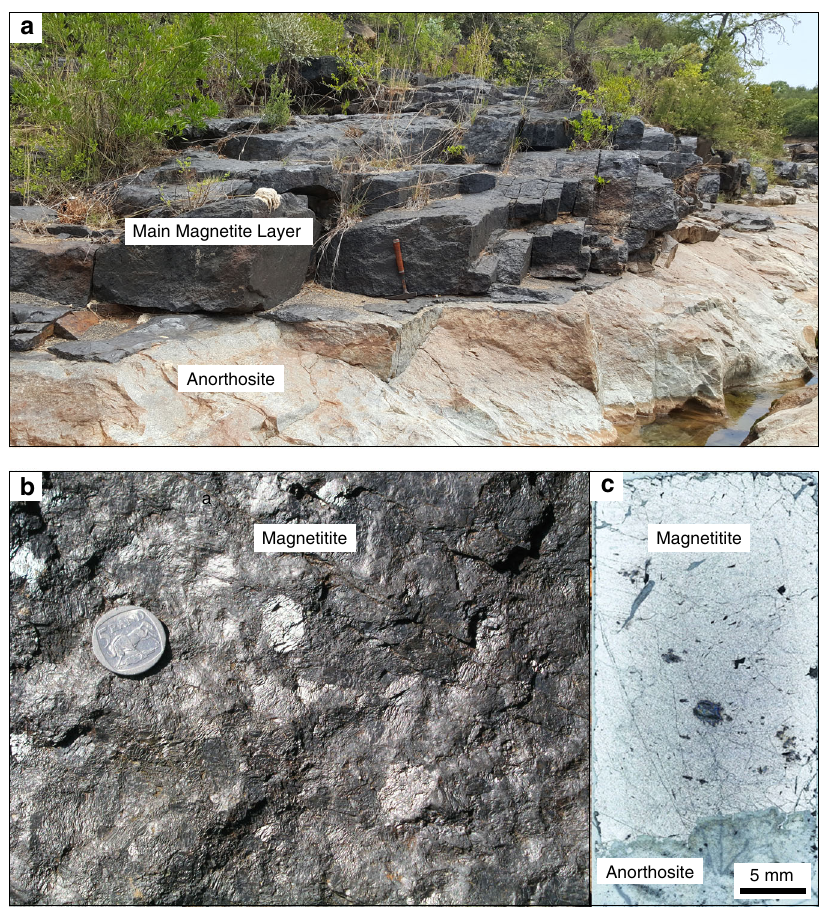
Fig. 2 The Main Magnetite Layer at Magnet Heights from the Eastern Bushveld Complex. a Field photograph of an outcrop of the MML with footwall anorthosites. The length of a hammer shaft is about 40 cm. b Field photograph of massive magnetitite from the MML. Sunlight re fl ected of individual titano-magnetite grains reveal the large grain size (typically more than 1 cm in size) and generally planar to slightly curved grain boundaries. Grains are typically polygonal with 120° triple-point grain boundary junctions, typical of monomineralic rocks in which textural equilibrium has been obtained. The coin has a diameter of 26 mm. c Photomicrograph in re fl ected light of the base of the MML including a portion of its underlying anorthositic footwall. Notice the near-perfect adcumulate and massive nature of the magnetite with virtually no intercumulus phases